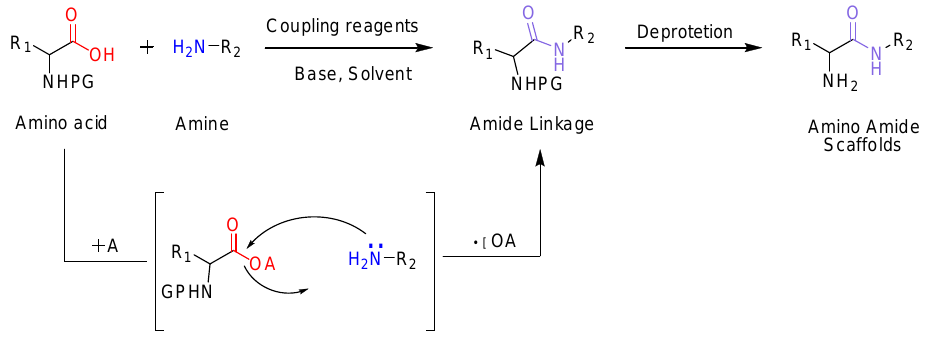
Scheme 1. A conventional approach for construction of simple amino amide scaffolds.